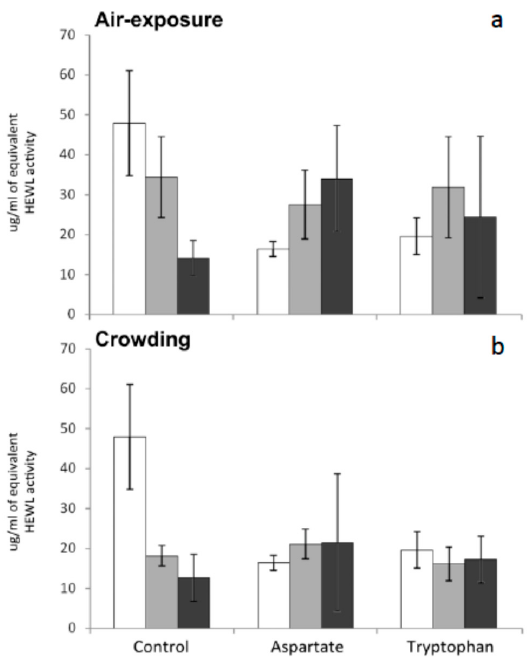
Figure 4. Lysozyme activity ( µ g mL − 1 of equivalent hen egg white lysozyme activity) in fish stressed by ( a ) air-exposure or ( b ) crowding. Results are shown as mean ± standard error. Non-stressed fish (white bars), 1 h post stress (grey bars) and 6 h post stress (black bars). Differences were considered significant when p < 0.05.